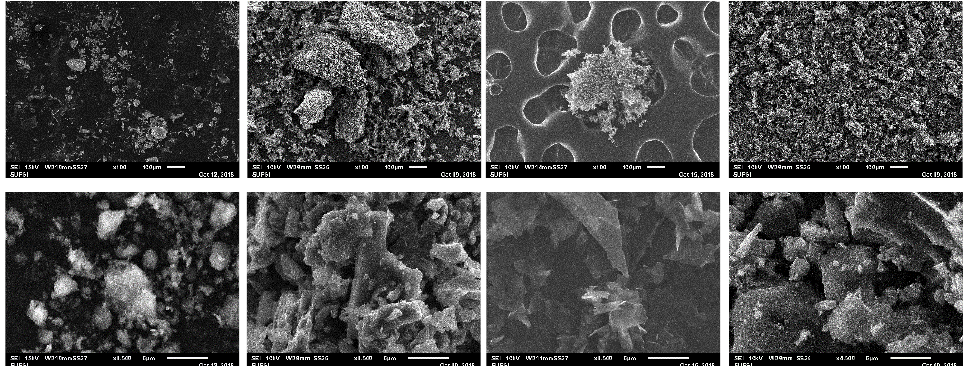
Figure 1. Scanning electron microscopy observation at 100 × ( top ) and 4500 × ( bottom ) for from the left zeolite, biochar, graphene and powdered activated carbon.